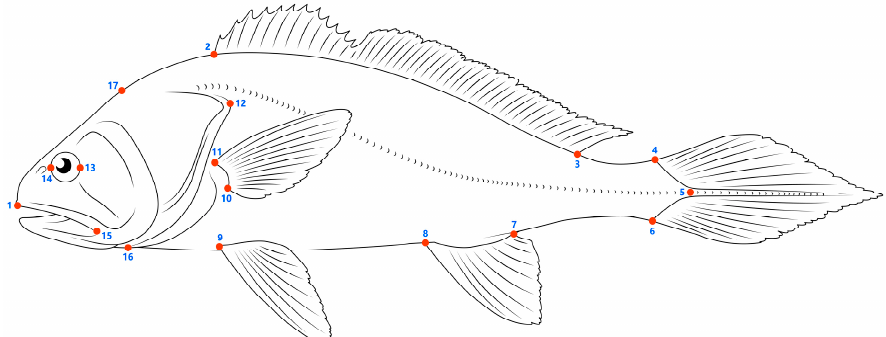
Figure 2. Graphical representation of P. magdalenae and landmarks used in this study. 1. Upper tip of the mouth. 2. First spine of the dorsal region. 3. Posterior insertion of dorsal fin. 4. Dorsal base of caudal fin. 5. Ventral insertion of caudal fin. 6. Ventral base of caudal fin. 7. Posterior insertion of anal fin. 8. First spine anal. 9. Anterior base of first pelvic fin ray. 10. Inferior insertion of pectoral fin. 11. Superior insertion of pectoral fin. 12. Dorsal border of preoperculum. 13. Posterior border of eye. 14. Anterior border of eye. 15. Cleft of the upper lip. 16. Anterior margin of the cleithrum. 17. Middle prefrontal region.